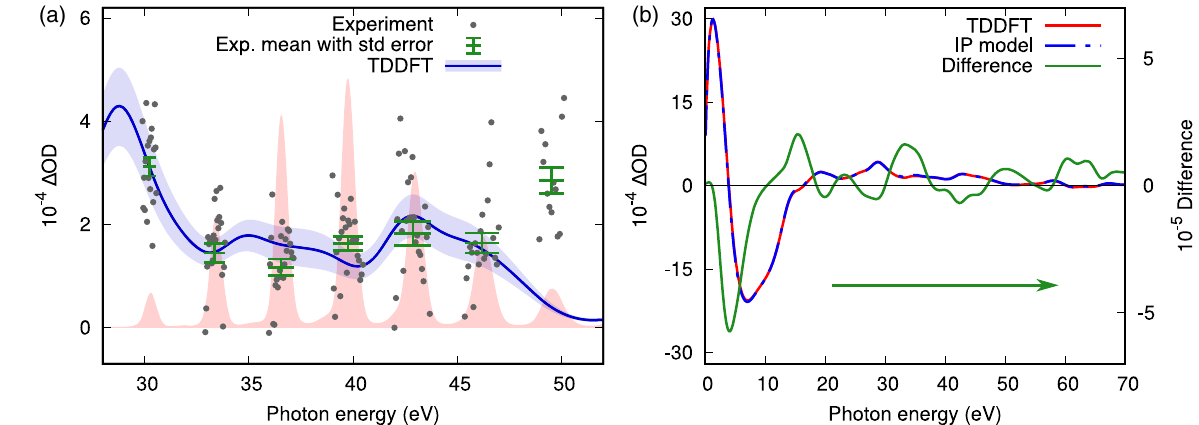
FIG. 2. Spectrally resolved change in optical density of aluminum, recorded at a delay of 20 fs, corresponding to a hot-electron/cold- lattice state. (a) Individual measurements (gray dots) and their spectral average, with the standard error over individual harmonics (green markers), shown at a fixed pump-probe delay of 20 fs and exhibiting an increase in optical density Δ OD towards lower photon energies. The red-shaded area in the background corresponds to the XUV probe spectrum. The TDDFT calculations (blue line) were computed by increasing the electron temperature to 7000 K and taking the difference of the absorption coefficient between the hot- and cold-electron states. (b) Full TDDFT (red line) and IP calculation (dashed blue